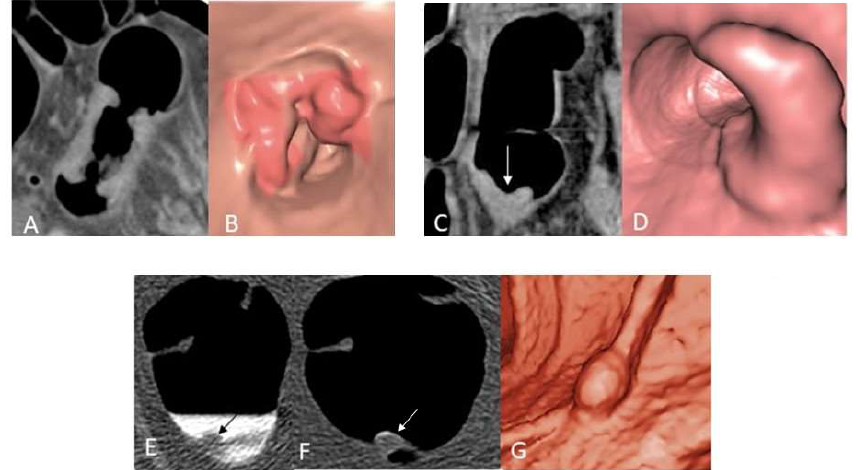
Figure 3. ( A – G ) Colon cancer and polyp presentation in CT colonography in three subjects. Stenosing colon cancer in 2D ( A ) and 3D (virtual endoscopy) ( B ) images in subject 1. Vegetating colon cancer (arrow) in 2D ( C ) and 3D (virtual endoscopy) ( D ) images in subject 2. Colon polyp (arrow) in source 2D images obtained in supine ( E ) and prone ( F ) position and in a 3D (virtual endoscopy) ( G ) image in subject 3.